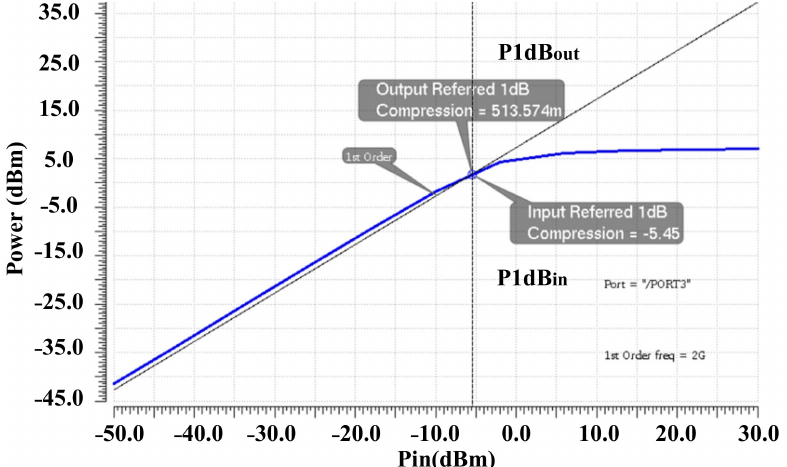
Figure 11. Input-referred 1-dB comparison point, P1dB IN , and output-referred 1-dB comparison point, P1dB OUT .